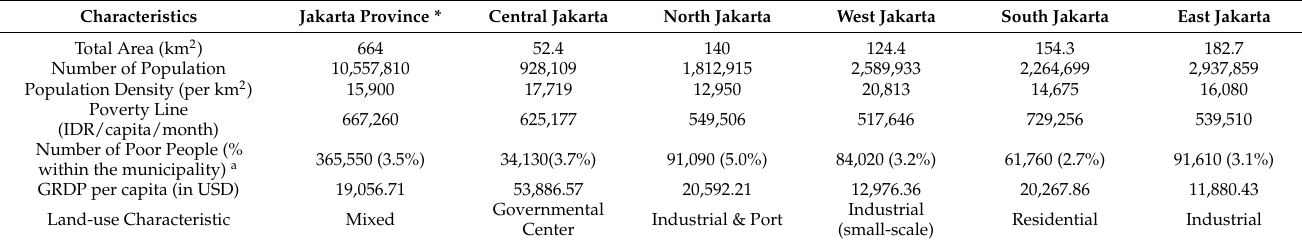
Table 4. Demographic characteristics of Jakarta Province and the five cities.